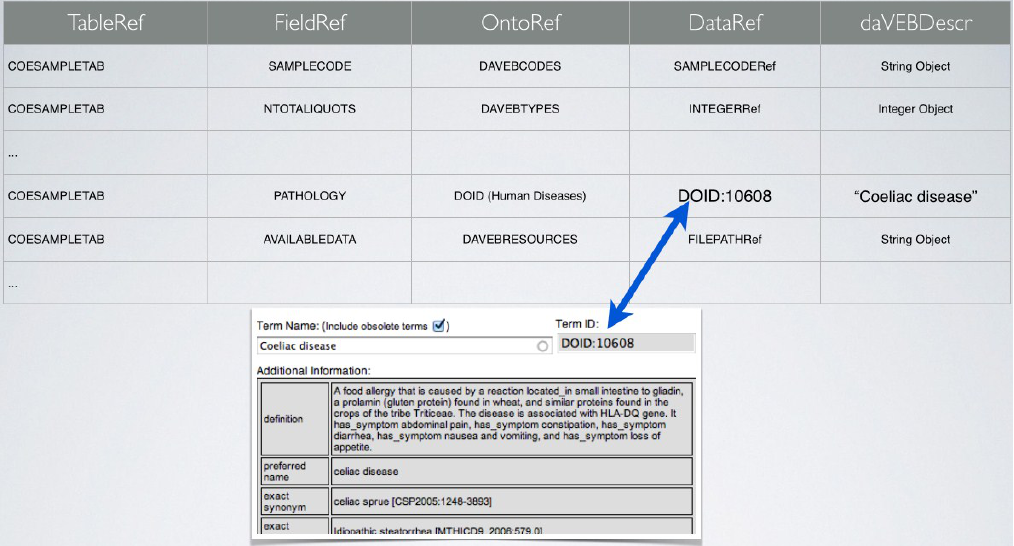
Figure 3. Example of first-level daVEB metadata